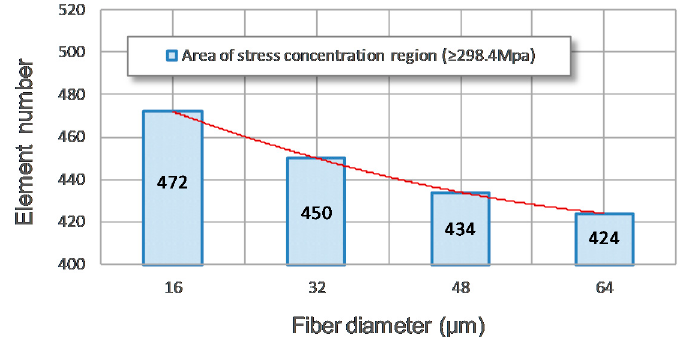
Figure 18. Area of stress concentration region ( ≥ 298.4 MPa) for the four stress fields with increasing SiC fiber diameters.